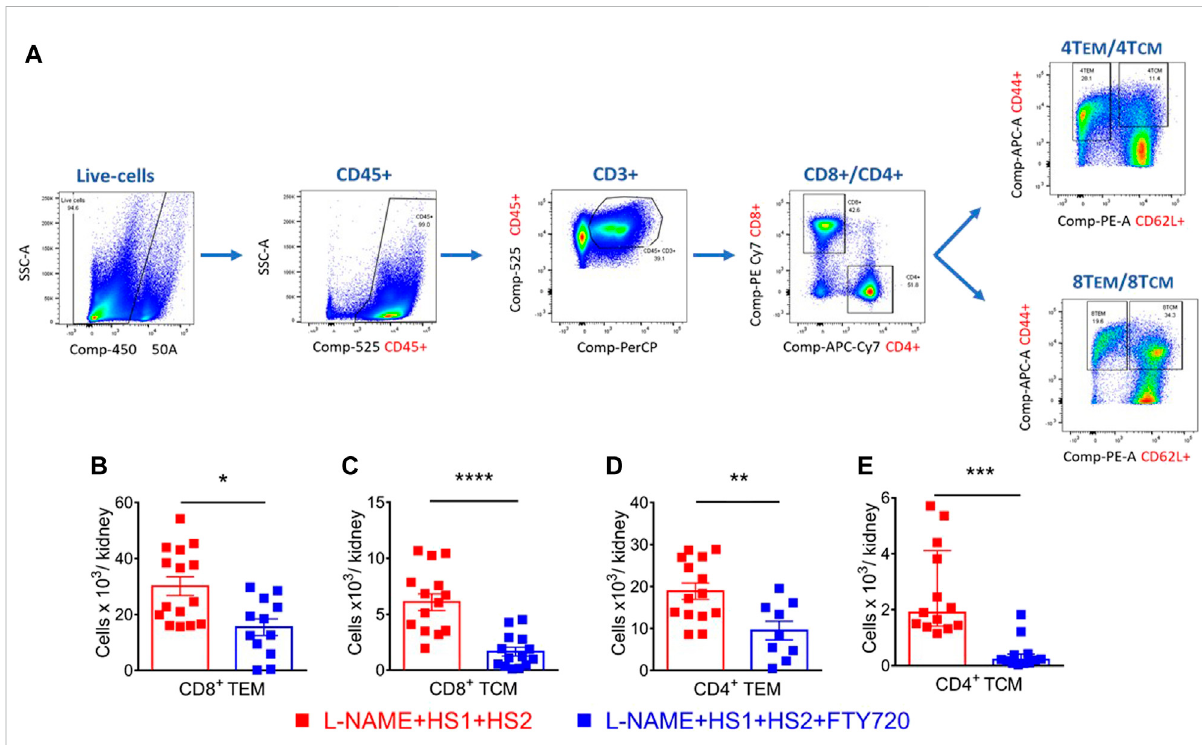
FIGURE 2 S1PR1pharmacologicalblockade,via fi ngolimod,inhibited renalin fl ammationand protectedfrom renalinjury inresponseto ahighsaltdiet. (A) Representative fl ow cytometric gating strategy of kidney single-cell suspensions showing the effect of L -NAME followed by high salt exposure on total leukocytes (CD45 + expression), total T lymphocytes (CD3 + ), total CD8 + and CD4 + T cells, CD8 + and CD4 + CD44hi/CD62Llo (TEM cells) and CD44hi/CD62Lhi (TCM cells). SSC-A indicates a side scatter area. (B – E) Summary of fl ow cytometric quanti fi cation of absolute numbers of CD8 + and CD4 + TEM and TCM cells in fi ltrating the kidney in WT mice that received L-NAME + HS1+HS2± fi ngolimod. N = 9 – 16 mice/group. Normally distributed data are expressed as mean ± SEM (panels B, C and D); not normally distributed data are expressed as median ± IQR (panel E) (Supplementary table 1). p -values calculated by unpaired t -test were shown. ** p < 0.01, *** p < 0.001, **** p <